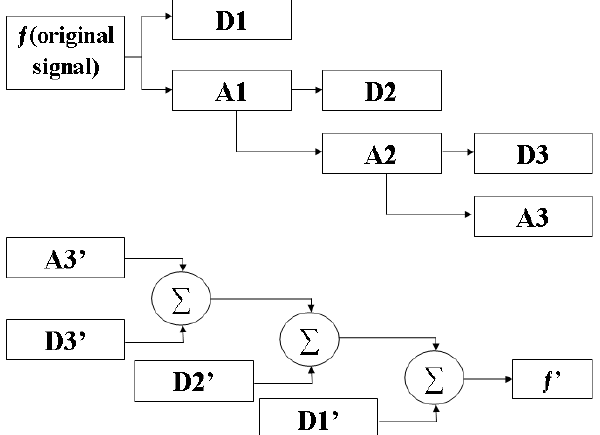
Figure 1. Multilevel decomposition (top) and reconstruction (bottom)